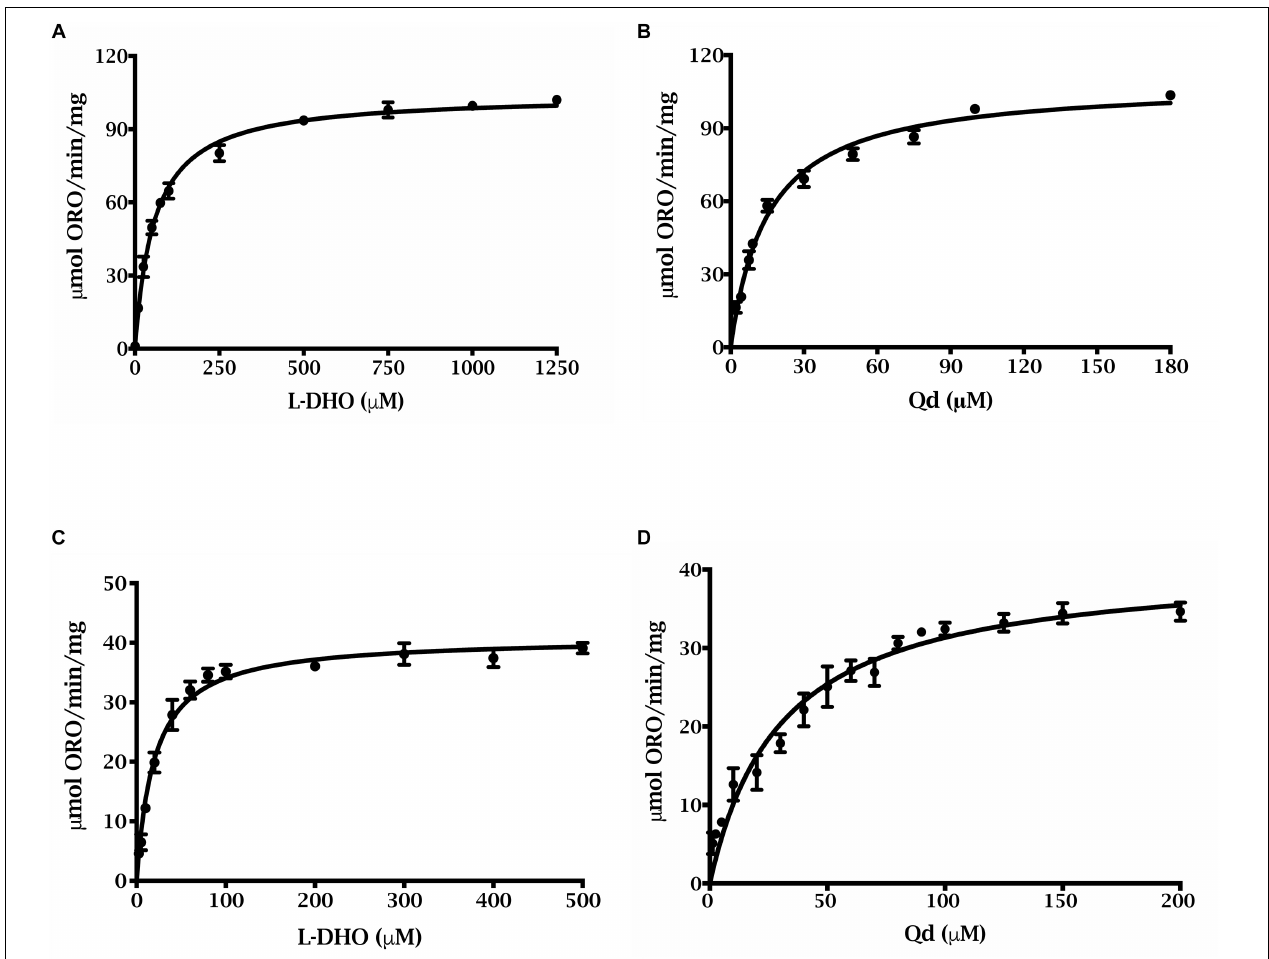
FIGURE 3 | Steady state kinetics of of purified truncated recombinant P. infestans and S. tuberosum DHODHs. (cid:49) N54PiDHODH saturation curves for (A) L -dihydroorotate and (B) decylubiquinone are shown. (cid:49) N69StDHODH saturation curves for (C) L -dihydroorotate and (D) decylubiquinone are shown. All curves were fit to the Michaelis–Menten equation, v = (V max · [S])/(K m +